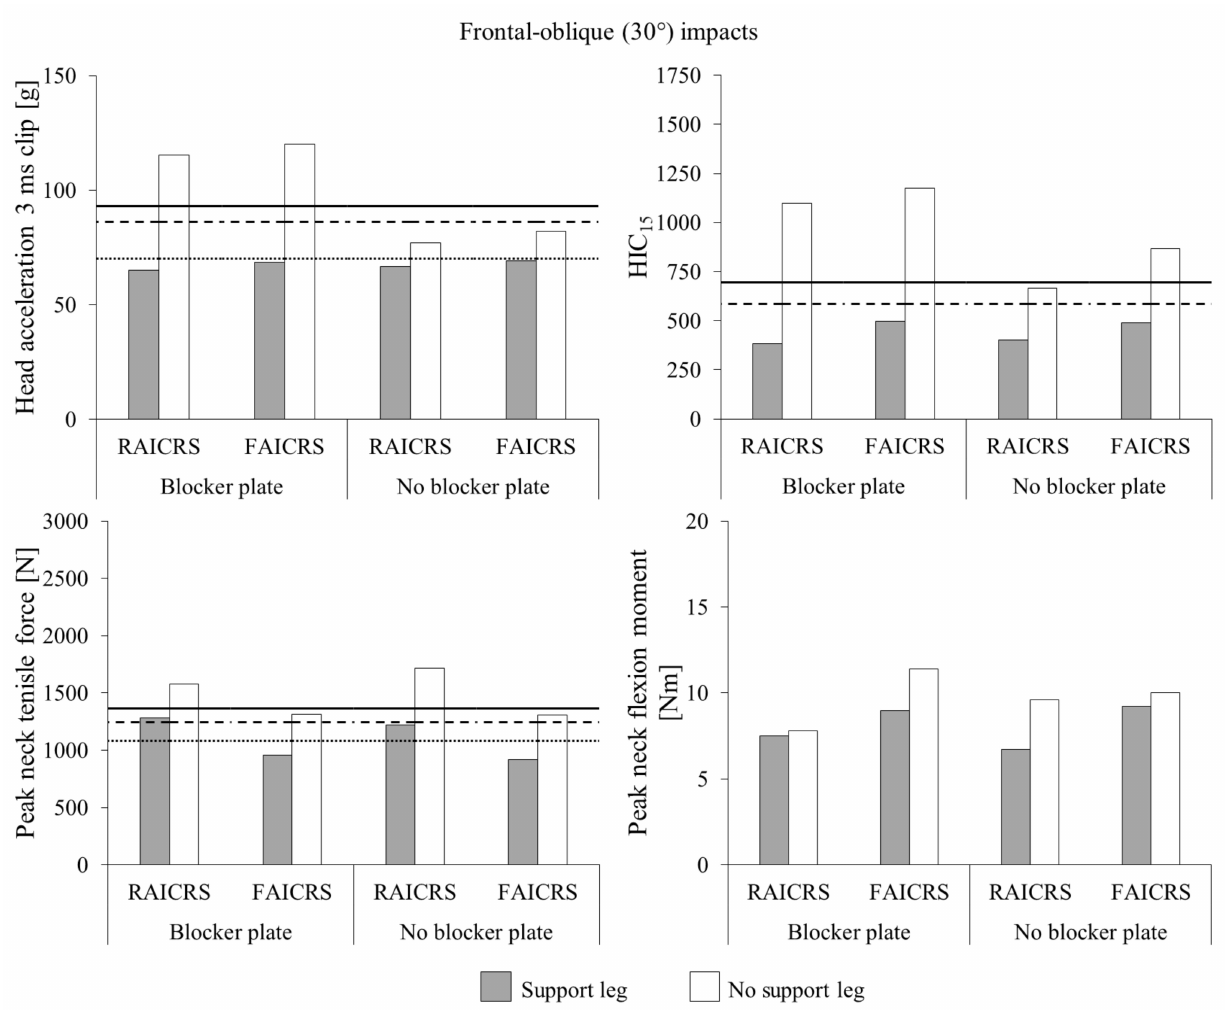
Figure 4. Head and neck injury metrics for the Q1.5 ATD in rearward-facing CRS models during frontal-oblique (30 ◦ ) impacts with (shaded bars) and without (unshaded bars) a support leg. Q1.5 ATD injury tolerance values (dotted lines) scaled from UN ECE R94 and 20% (dashed lines) and 50% (solid lines) risk of AIS3+ injury tolerance values from Wismans et al. [17]. Note that there is no tolerance value scaled from UN ECE R94 for HIC 15 and injury tolerance values for peak neck flexion moment are beyond the scale of the axis. RAICRS: rigid anchor infant child restraint system. FAICRS: flexible anchor infant child restraint